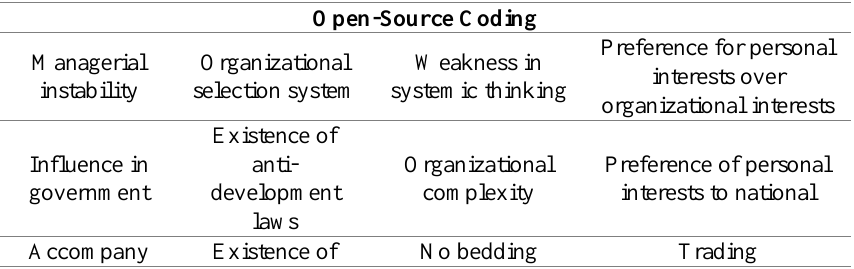
Table 2. Open-source coding of the